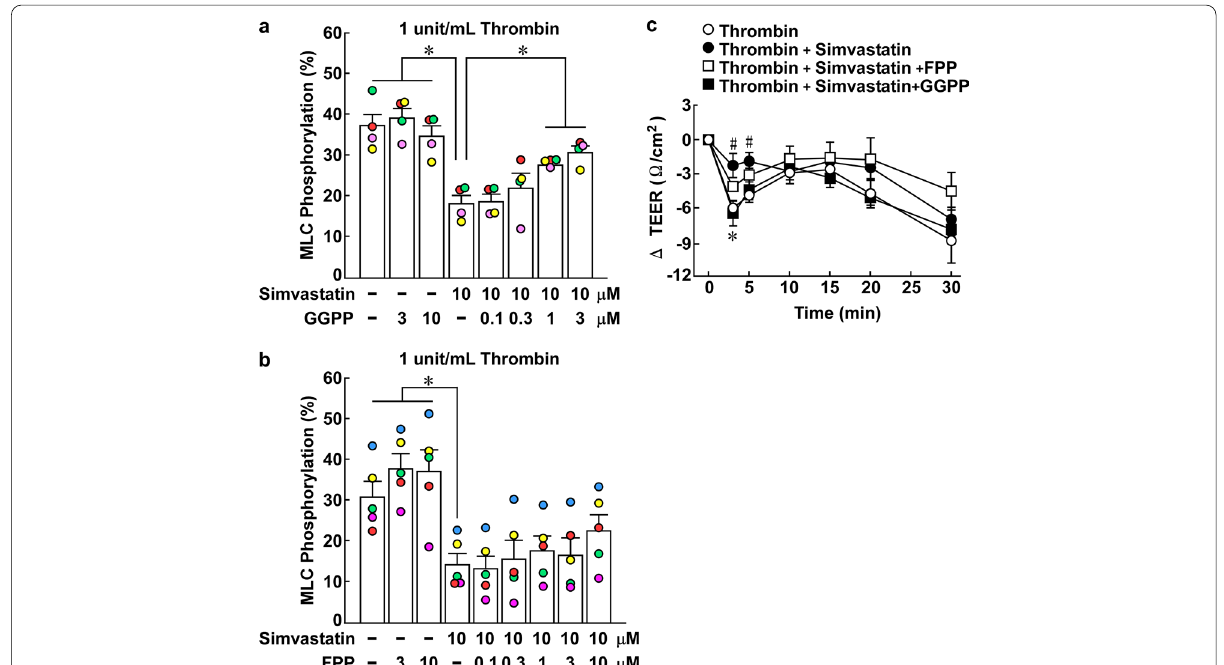
Fig. 2 Effects of geranylgeranyl pyrophosphate (GGPP) and farnesyl pyrophosphate (FPP) on the inhibition by simvastatin of the thrombin-induced di-phosphorylation of myosin light chain (ppMLC) and decrease in the trans-endothelial electrical resistance (TEER) in porcine aortic endothelial cells (PAECs). a , b The effects of simvastatin and GGPP (a; n 4) or FPP (b; n 5) on the thrombin-induced ppMLC were summarized. PAECs were = = pretreated or left untreated with simvastatin, GGPP or FPP, either alone or their combination, at the indicated concentrations for 16 h. The cells were then stimulated with 1 unit/mL thrombin, in the presence of simvastatin, GGPP or FPP, when pretreated. The levels of ppMLC were evaluated 3 min after thrombin stimulation. All original images of the immunoblot analyses in panels a and b are shown in Additional file 1: Figure S2. c Shown are the time courses of the change in the TEER after stimulation with 1 unit/mL thrombin in PAECs with and without pretreatment with 10 µM simvastatin, 3 µM GGPP or 10 µM FPP, as indicated ( n 5). The data are expressed as the mean SEM. * P < .05 vs. simvastatin ( a , b ) and = ± thrombin simvastatin ( c ); # P < 0.05 vs. thrombin ( c ), according to an ANOVA followed by Dunnett’s post hoc +